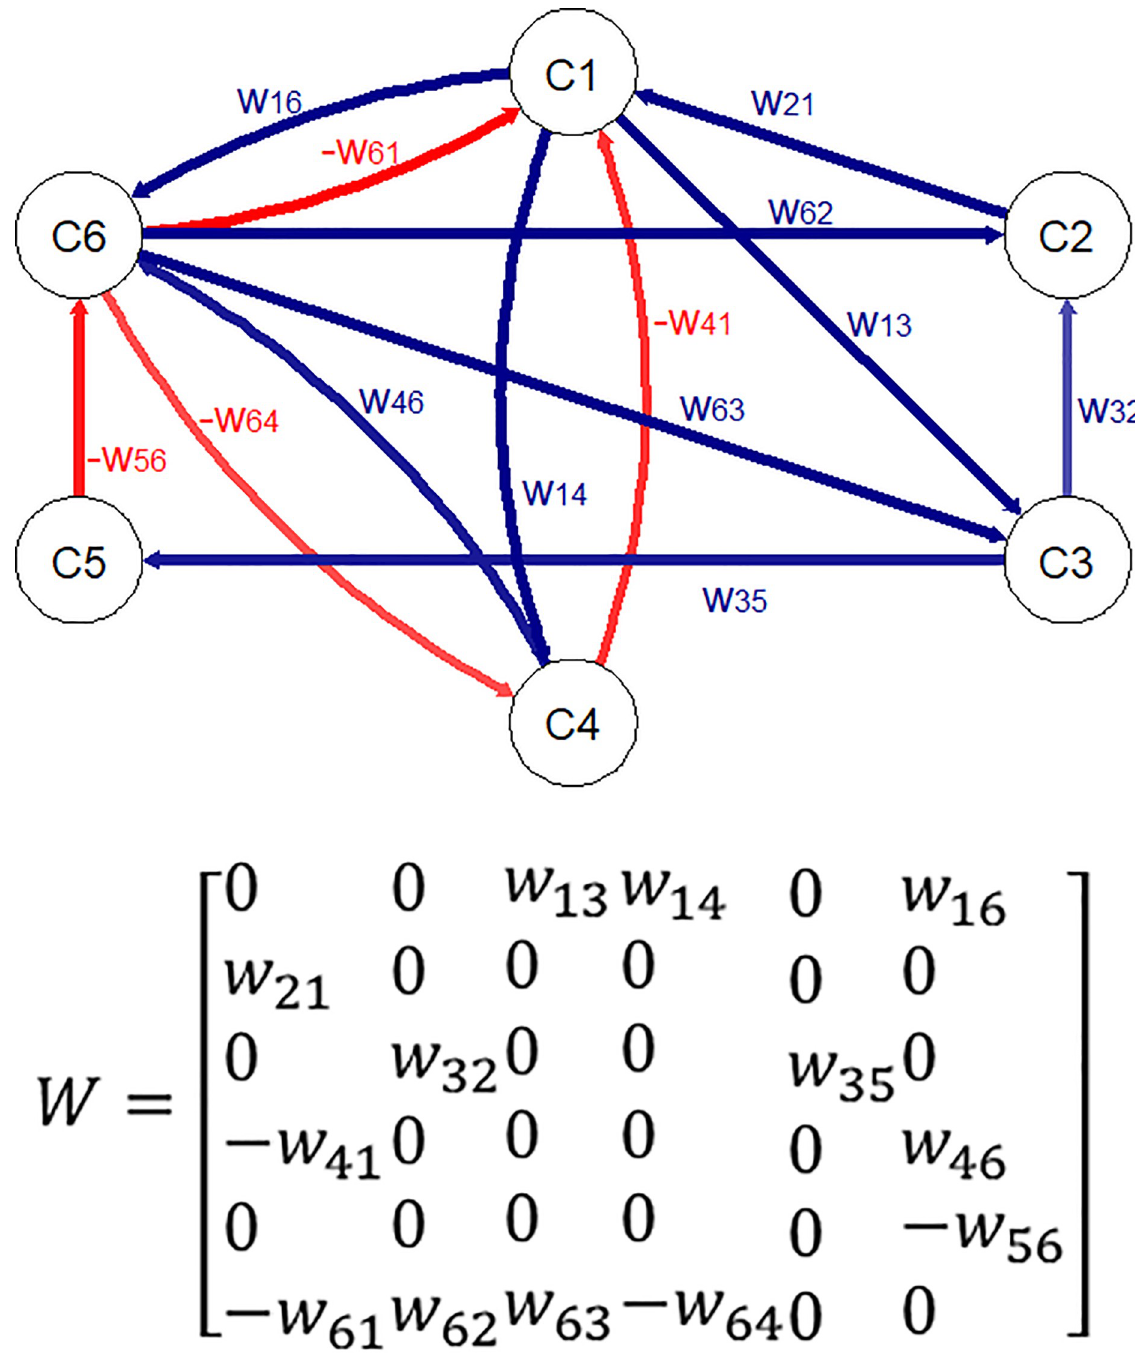
Fig 2. Fuzzy cognitive map (left) and the correspondent adjacency weight matrix